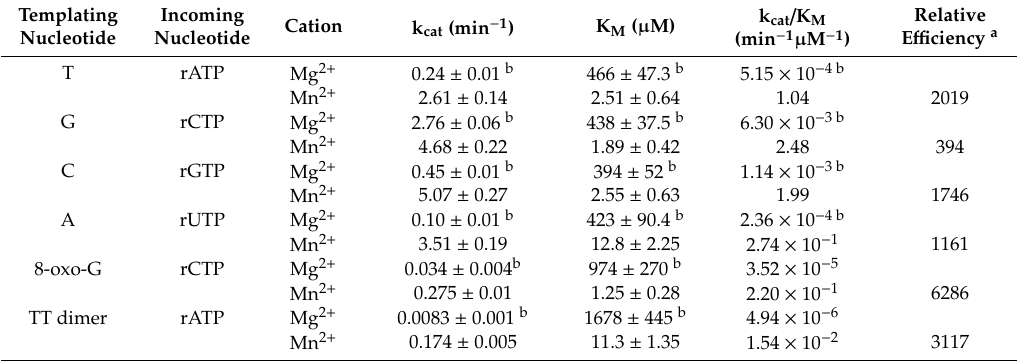
Table 1. Comparison of the kinetic parameters of rNTP incorporation into RNA by Pol η using Mg 2 + or Mn 2 + as